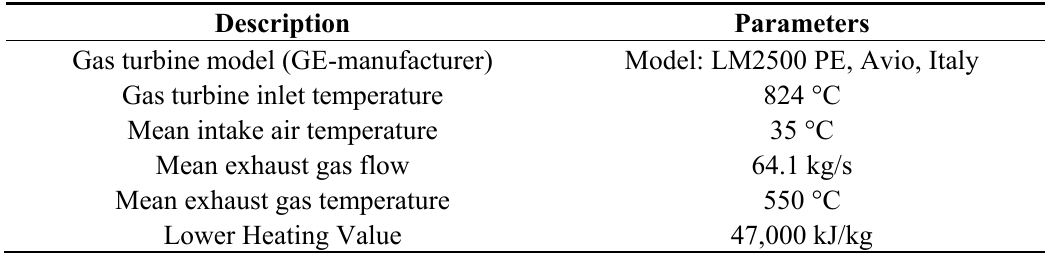
Table 2. Technical specifications of gas turbine power plant.